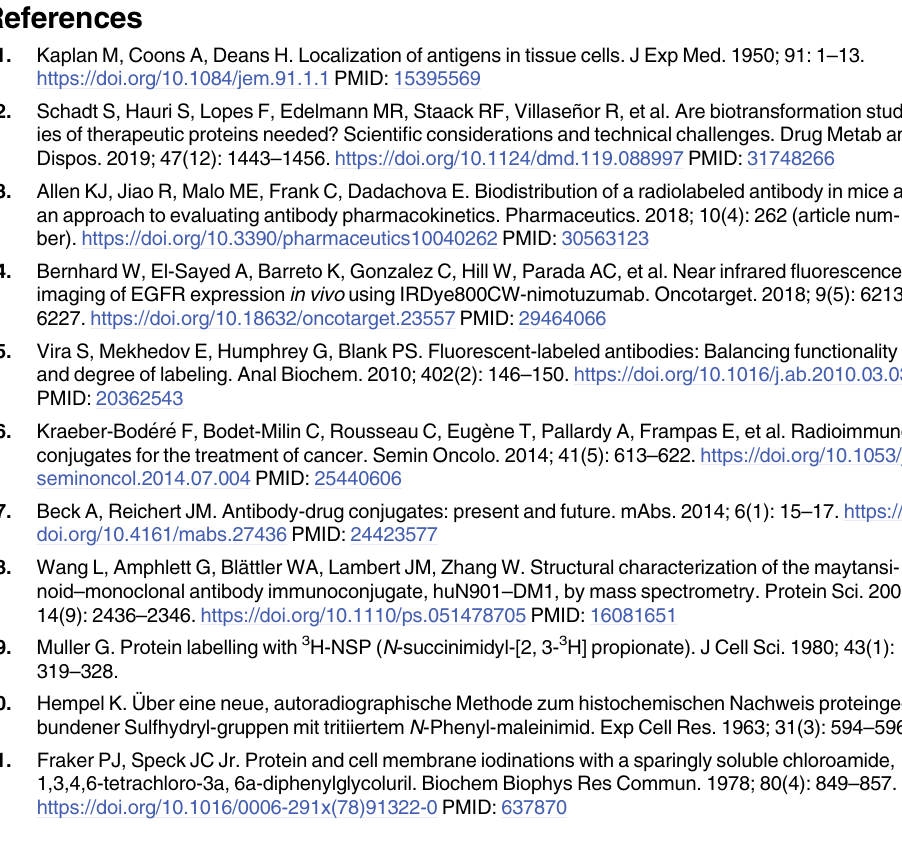
series. Left column: SEC; cen- B